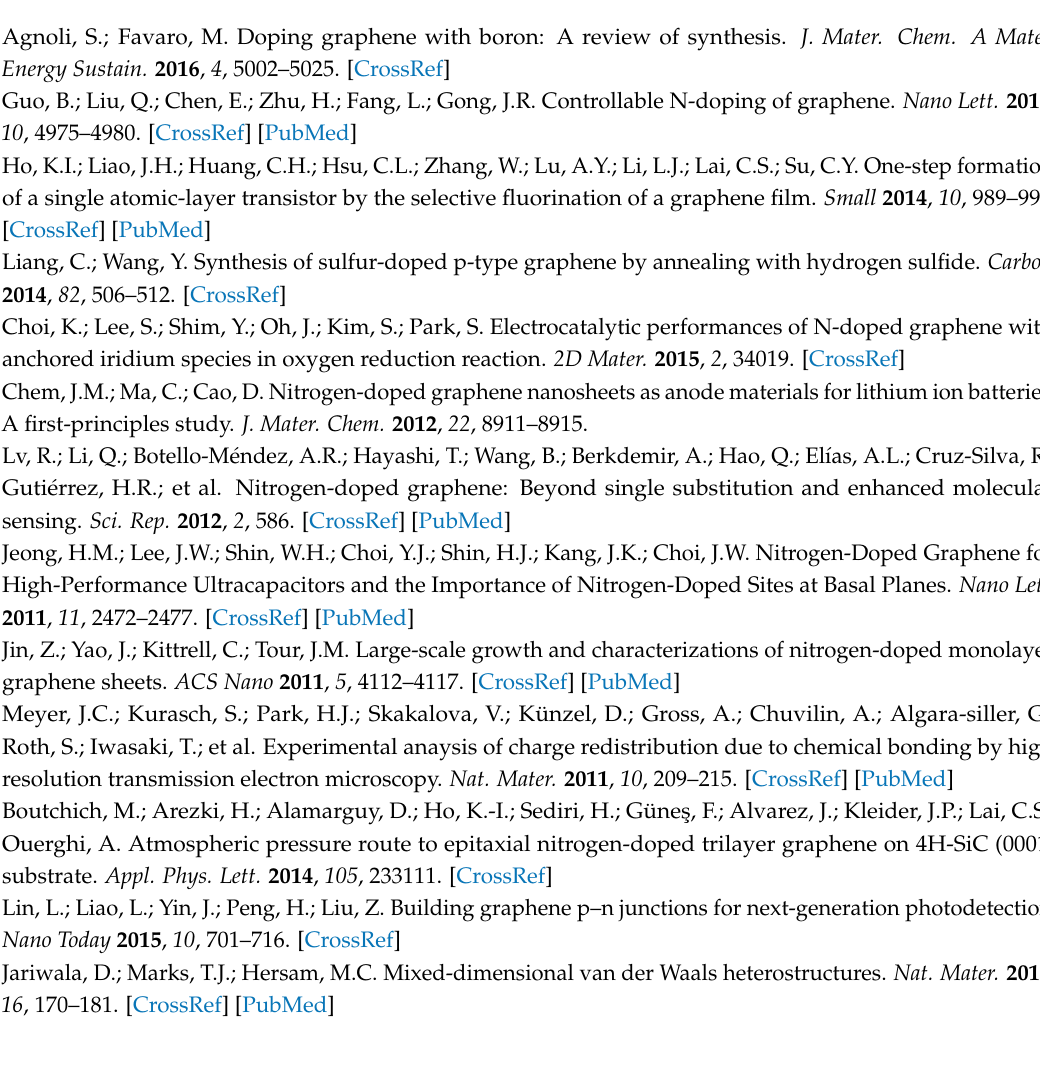
Figure S1: XPS spectra for N-doped graphene. (a,b) C1s core level for NG3 and NG5; (c,d) N1s core level for NG3 and NG5. Figure S2: Raman spectrum of graphene without and with a 1 min, 3 min, and 5 min NH 3 plasma treatment. Figure S3: (a) The I g / V g curve of pristine graphene and N-doped graphene; (b) the I d / V d curve of pristine graphene and N-doped graphene; (c) gate capacitance of pristine graphene and N-doped graphene, the inset illustration shows the structure of the capacitance